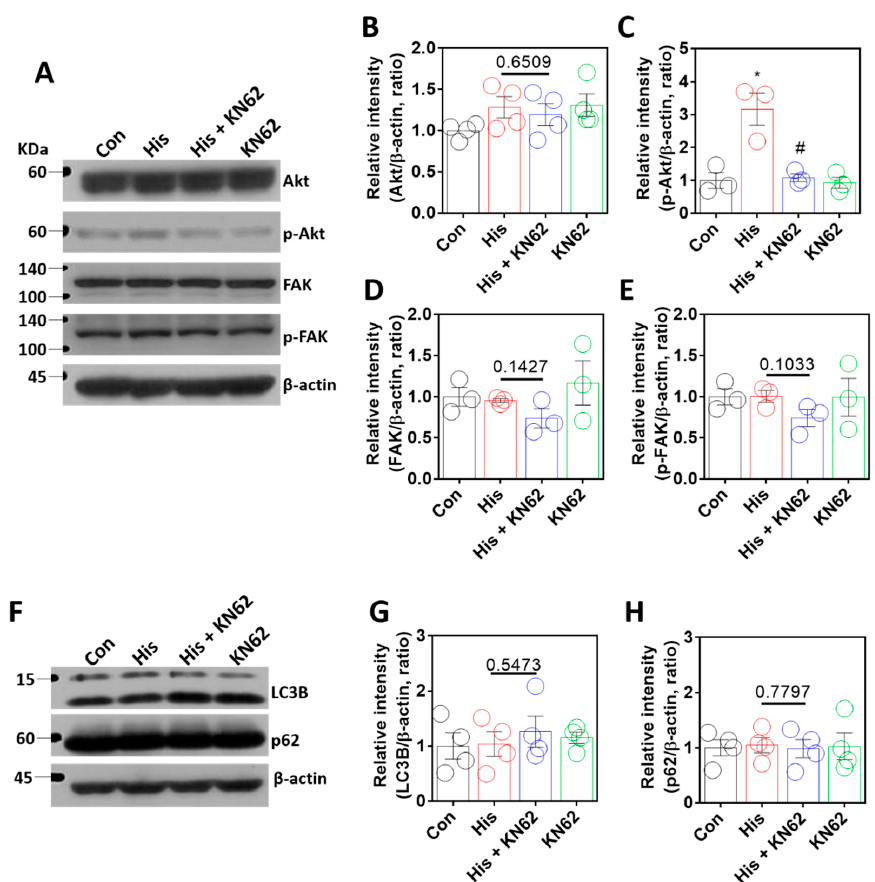
Figure 5. Histamine-mediated lamin-A/C expression was independent of Akt/FAK or autophagy signaling. ( A ) Protein expression levels of Akt, p-Akt, FAK, and p-FAK after histamine (His) treatment (100 µ M, 24 h) with or without KN-62 (10 µ M, 24 h) in A549 cells. The graph indicates relative intensity of ( B ) Akt and ( C ) p-Akt. The bars represent the mean ± SEM ( n = 3~4, * p < 0.05 vs. control and # p < 0.05 vs. His-treated group). The graph indicates relative intensity of ( D ) FAK or ( E ) p-FAK. The bars represent the mean ± SEM ( n = 3). ( F ) Protein expression levels of LC3B and p62 after histamine (His) treatment (100 µ M, 24 h) with or without KN-62 (10 µ M, 24 h) in A549 cells. The graph indicates relative intensity of ( G ) LC3B or ( H ) p62. The bars represent the mean ± SEM ( n = 4). β -actin was used as a loading